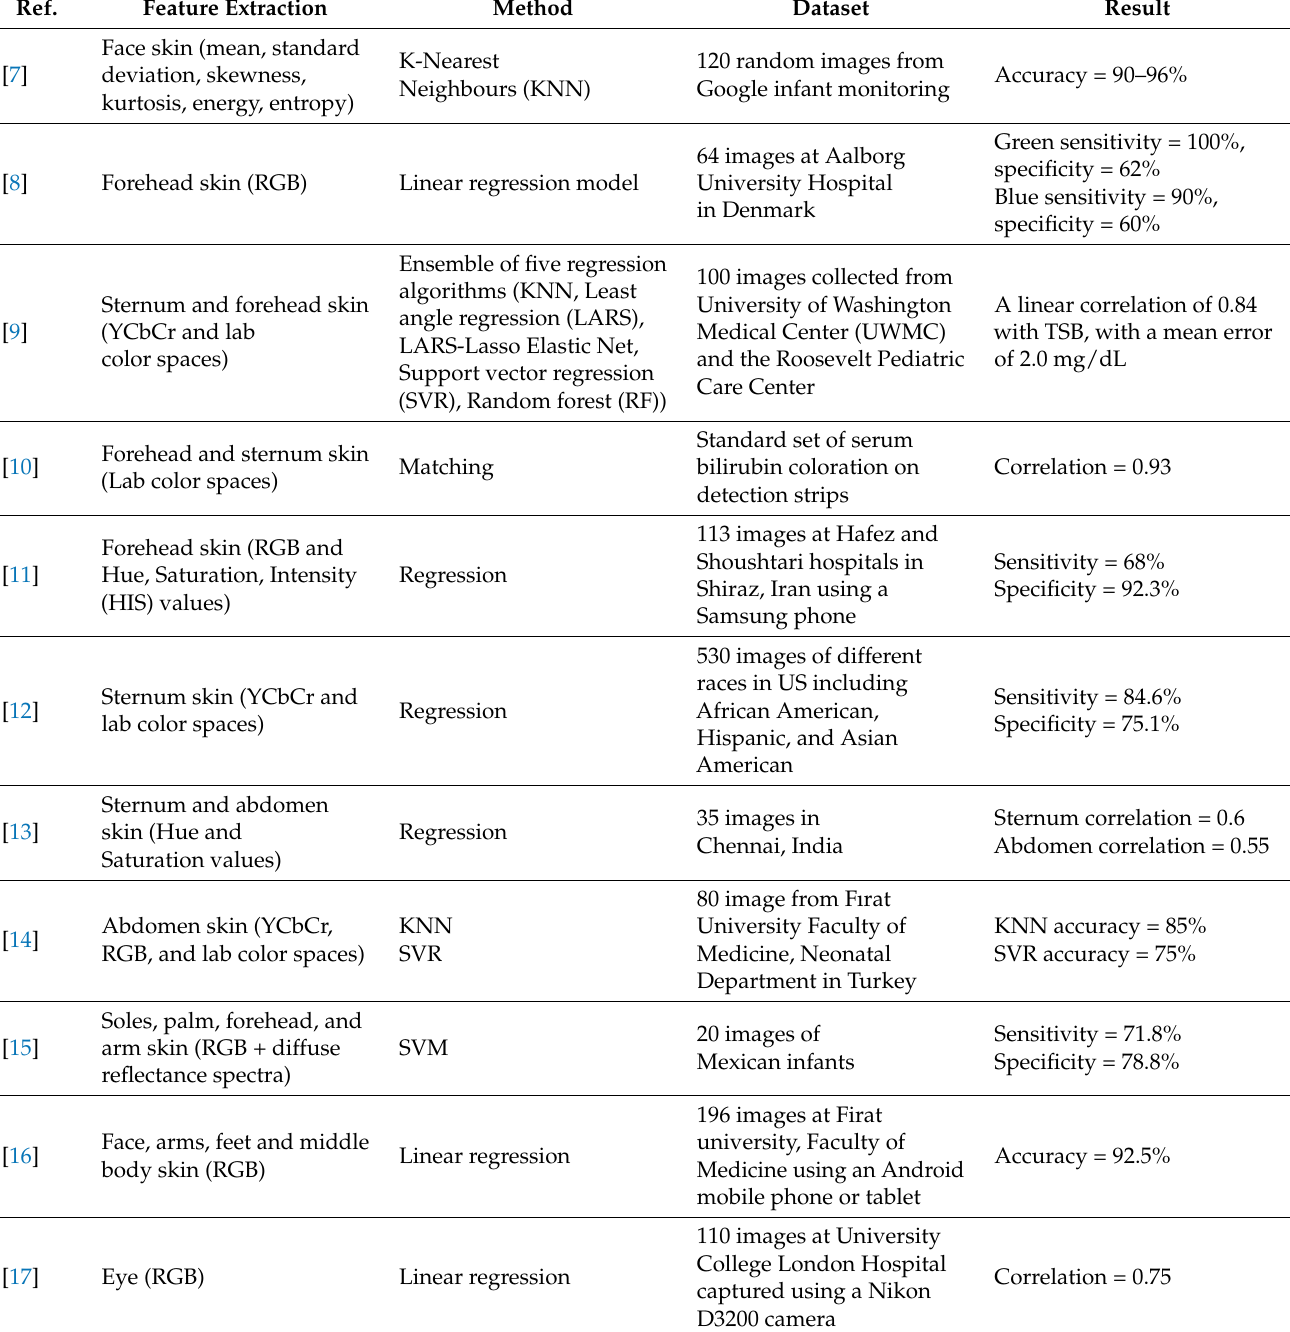
Table 1. Comparison of related works with their reported